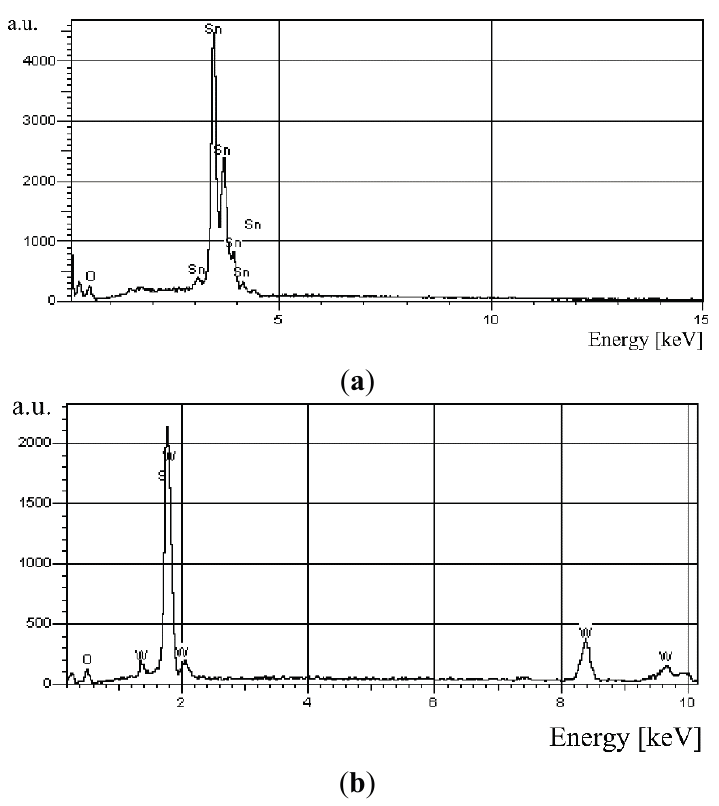
Figure 6. EDS spectrum of the layer: ( a ) SnO 2 ; ( b ) WO 3